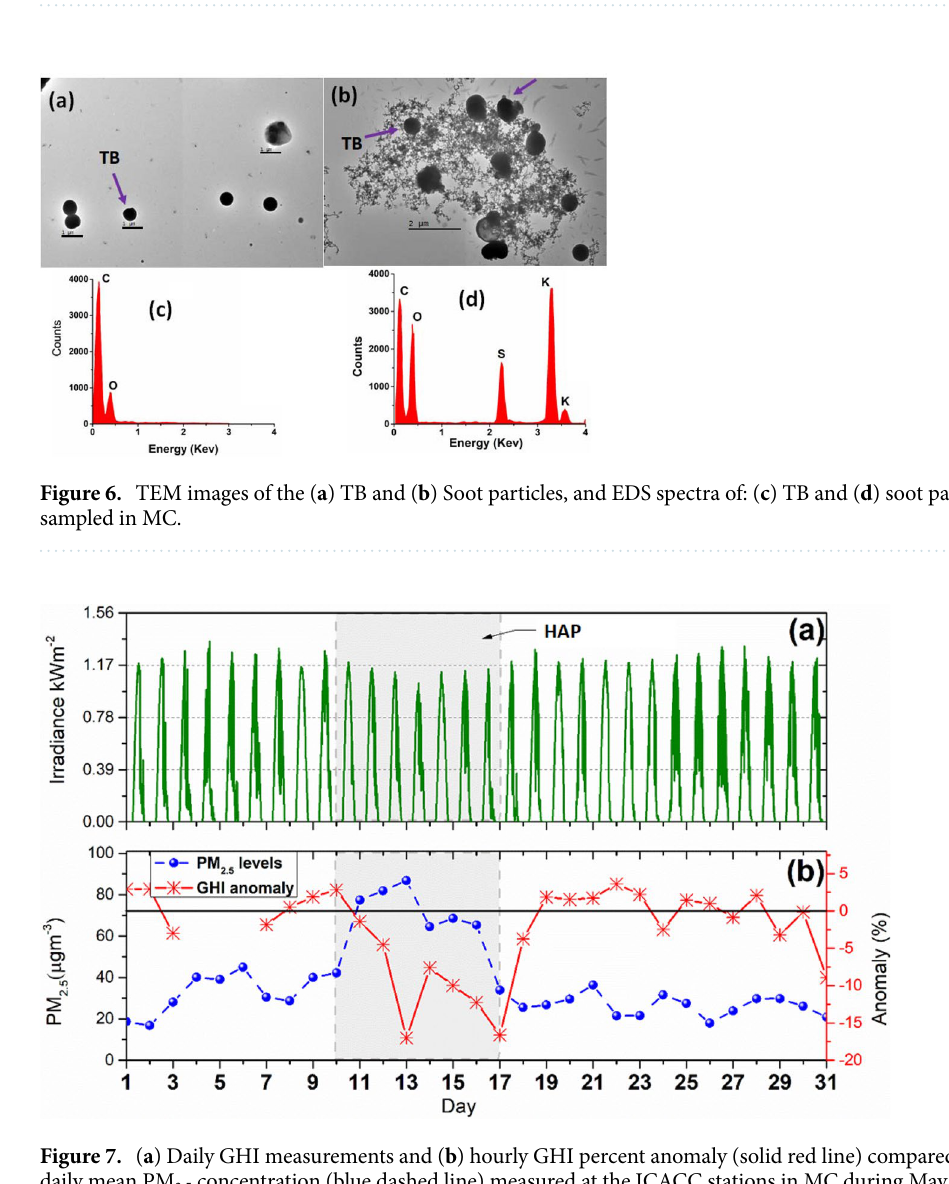
Figure 5. Visibility as a function of AOD values (at 500 nm) from AERONET. Visibility is estimated from β ext (532 nm) and calculated using Eq. (2).